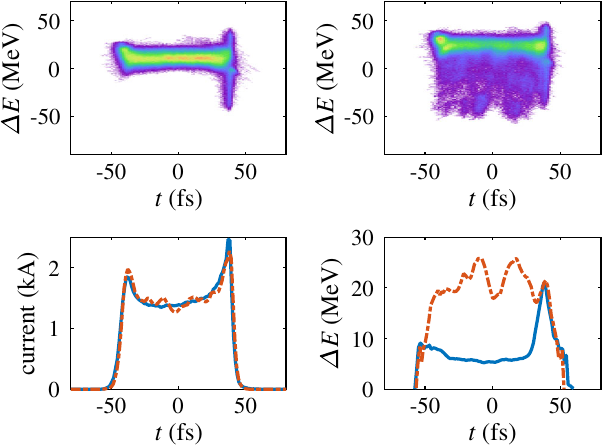
FIG. 10. Typical measured longitudinal phase space of the electron beam when lasing off (top left) and laser on (top right). Bottom-left: beam current profile and Bottom-right: slice energy spread profile of the two phase spaces for lasing off (solid line) and lasing on (dotted line).